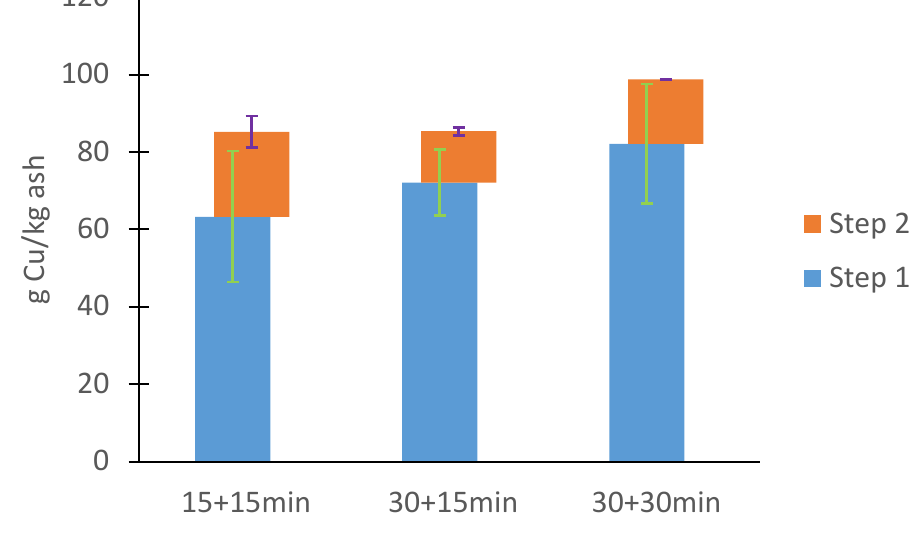
Figure 3. Cu leached from the bark-ash sample A1a using two-step leaching with different leaching times at an L/S ratio of 10. The columns show the average of duplicate tests. The error bars show the maximum and minimum